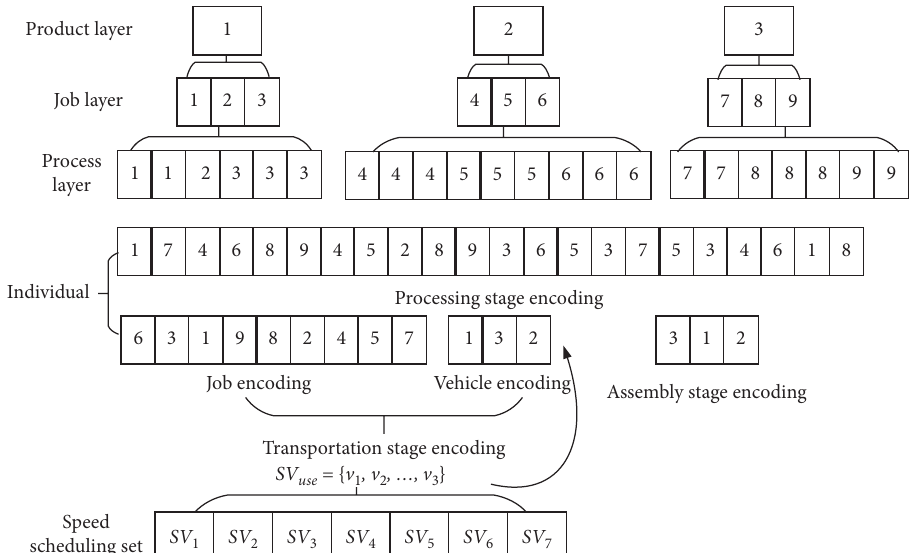
Figure 3: The coding method of scheduling